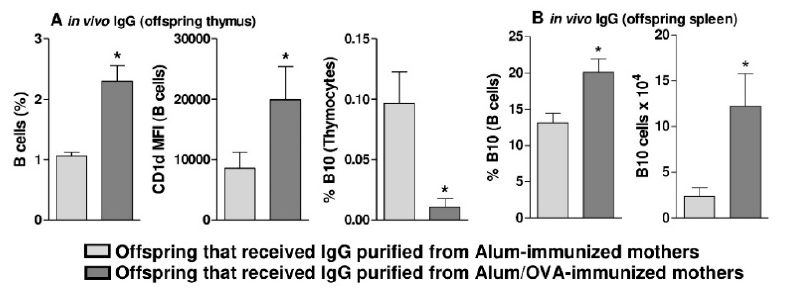
Figure 4. Frequency and number of o ff spring thymic B10 cells in response to maternal passive treatment with IgG. During gestation, normal females passively received 1600 µ g of purified IgG ( n = 5 females per group), and the frequency of total B cells, the intensity of CD1d expression, and the frequency of B10 cells in the thymus of 3-d.o. o ff spring ( n = 12–13 pups in each group; pups were delivered from five mothers in each group) were evaluated ( A ) We also assessed the frequency and number of B10 cells in the spleens of o ff spring in the same period and groups ( B ) Data are presented as the mean ± SEM. * p ≤ 0.05 compared with o ff spring that received IgG from the Alum-immunized mothers using Mann–Whitney U test.